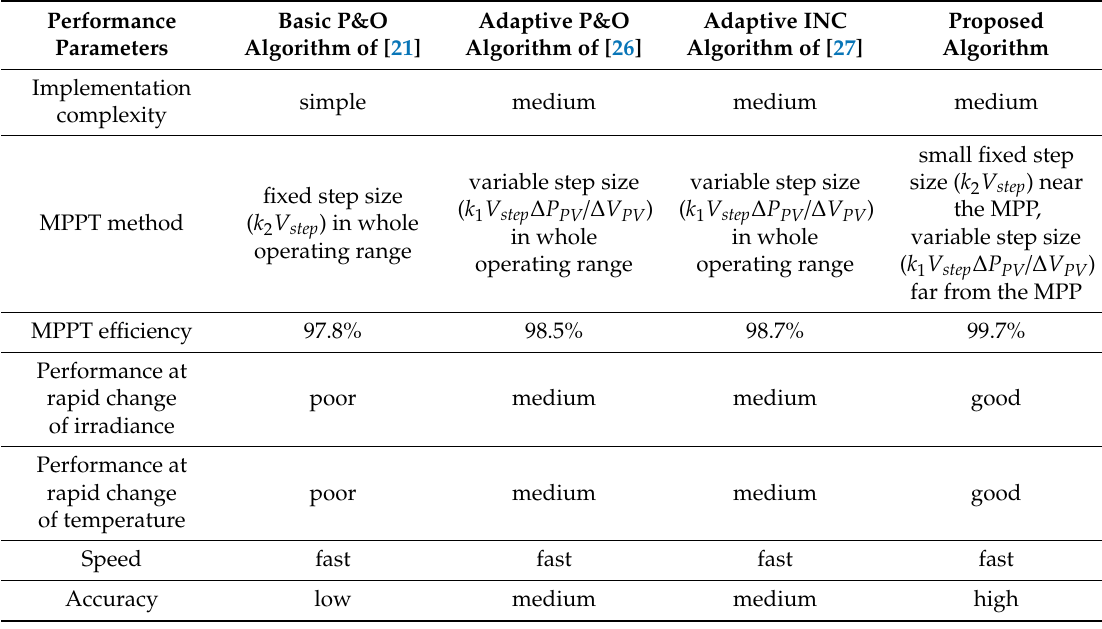
Figure 17. Power ( P PV ) waveforms of the PV module measured using ( a ) the basic P&O algorithm, ( b ) the adaptive P&O algorithm, ( c ) the adaptive INC algorithm, and ( d ) the proposed MPPT algorithm under abruptly changing temperature conditions. Table 5. Comparisons between the proposed and conventional MPPT algorithms.